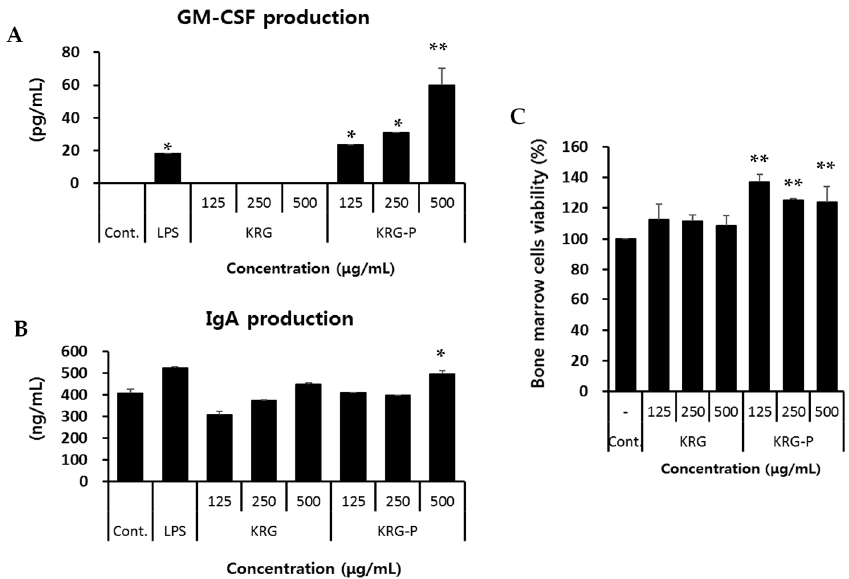
Figure 2. Effect of Korean red ginseng (KRG) and KRG-P on the immunomodulatory activity of intestinal Peyer’s patch cells. ( A , B ) In vitro GM-CSF and IgA production by Peyer’s patch cells was stimulated by KRG and KRG-P. Peyer’s patch cells (2.0 × 10 6 /mL) were treated with KRG and KRG-P in a 96-well plate for 4 days. The concentrations of GM-CSF and IgA in the Peyer’s patch cell supernatants were determined using ELISA kits. Lipopolysaccharide (LPS) was used as a positive control. Data are presented as the means ± SD of three independent experiments. ( C ) Bone marrow cell proliferation was induced by Peyer’s patches cells after treatment with KRG or KRG-P. Peyer’s patch cells (2.0 × 10 6 cells/well) were treated with KRG or KRG-P in a 96-well plate for 4 days. The supernatants collected from these wells were added to the bone marrow cells (3.0 × 10 5 cells/well) for 5 days. LPS was used as a positive control for bone marrow cell proliferation. Data are presented as the means ± SD of three independent experiments. * p < 0.05 vs. the normal group. ** p < 0.01 vs. the normal group.